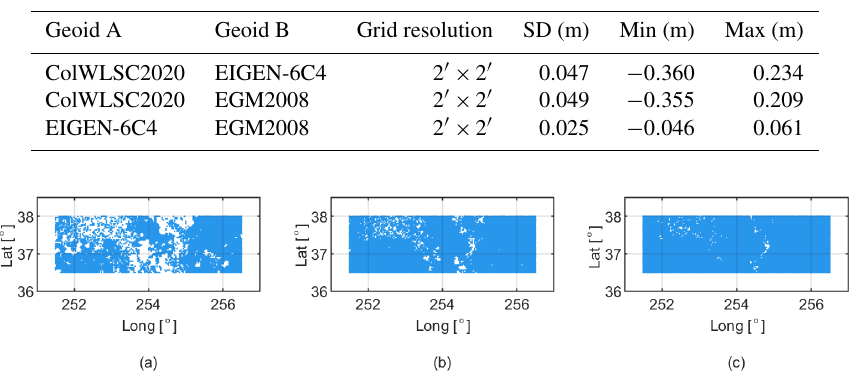
Table 3. Statistics of the differences between the analysed Colorado geoids.